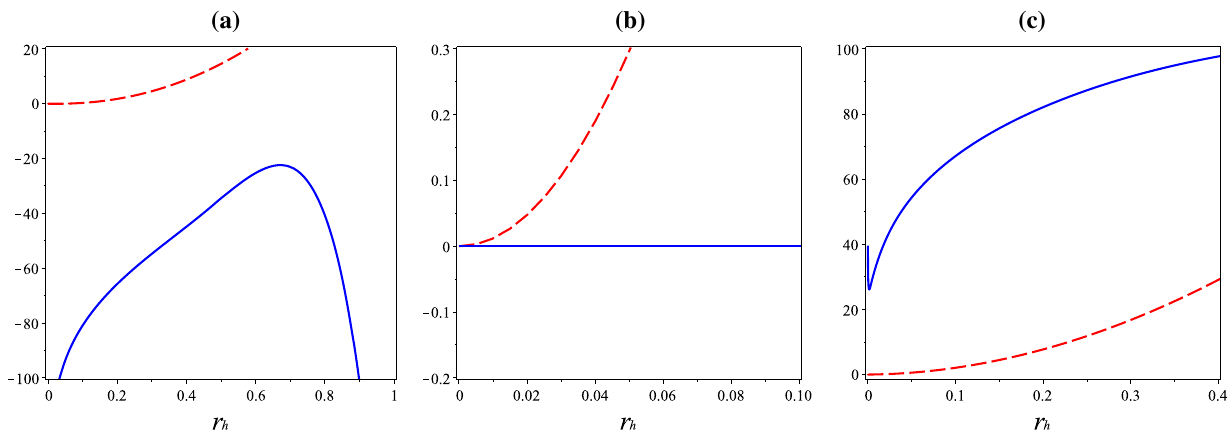
Fig. 10 Critical points of LMP solution in flat space for l = 1 and a = 10: a α = γ = − 1. b α = γ = 0. c α = γ = 1. Dashed red lines represent dP , while solid blue lines represent d 2 P dV dV 2